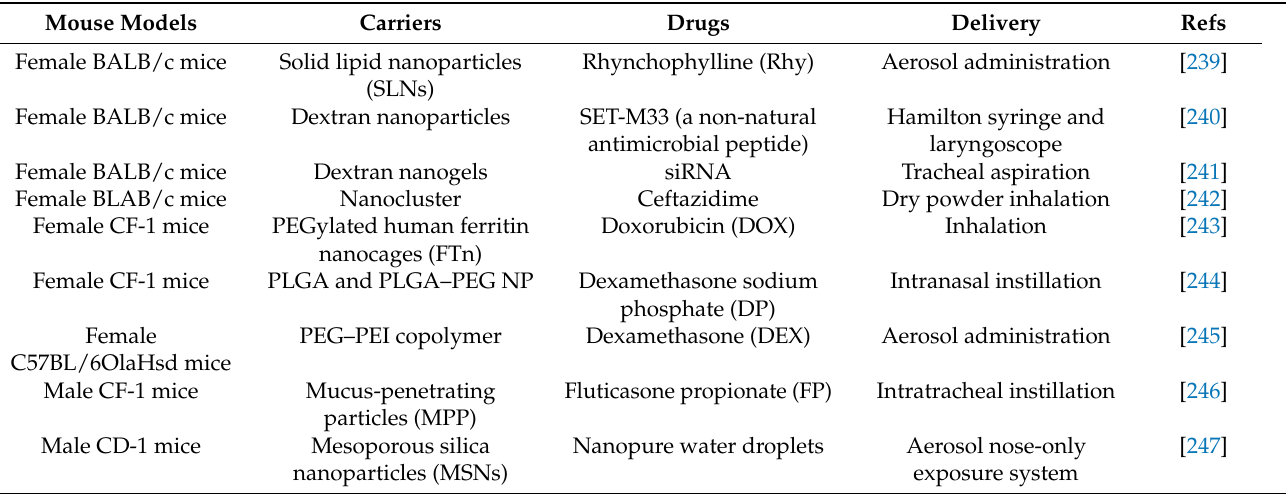
Table 3. Mouse models used to assess respiratory nanocarrier delivery.